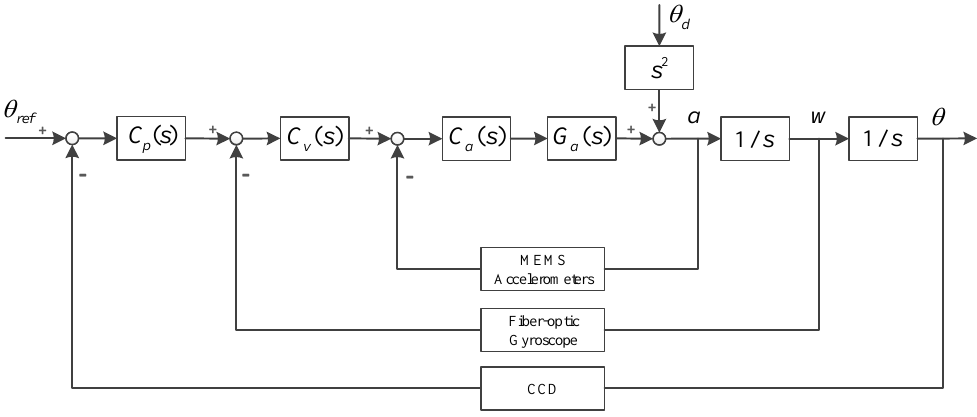
Figure 2. Schematic diagram of multi-loop feedback control (MFC) structure.